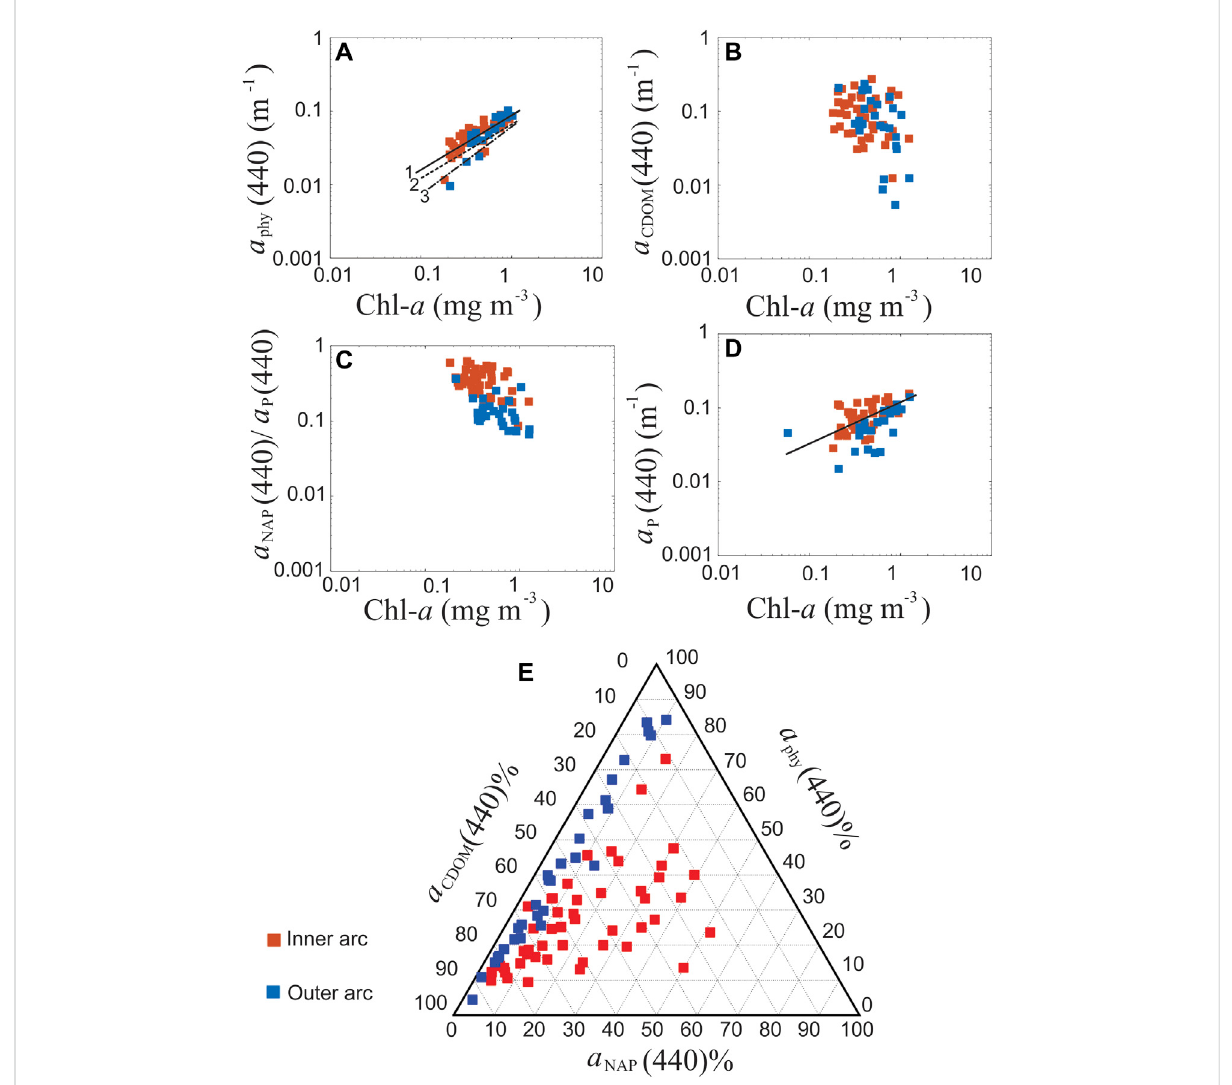
FIGURE 4 Relationshipbetweenmeasuredbio-opticalpropertiesandChl- a intheAbrolhosBankregion.Inallpanels,redsquaresrepresentsamplesinthe inner arc, while blue squares in the outer arc. (A) a phy (440) as a function of Chl- a (n = 68) (log scale). The solidline (line 1) shows the linear regression found in this study, while the dashed line (line 2), and dashed-pointed line (line 3) represent the empirical relationships in Bricaud et al. (2004), and in Bricaud et al. (2010), respectively. (B) a CDOM (440) as a function of Chl- a ( n = 71) (log scale). (C) a NAP (440)/ a p (440) as a function of Chl- a ( n = 71) (log scale). (D) a p (440) ( n = 69) as a function of Chl- a (log scale). (E) Ternary plot showing the fraction of total non-water absorption dominated by colored dissolved organic matter ( a CDOM ), phytoplankton ( a phy ), non-algal particulate ( a NAP ) at 440 nm ( n =